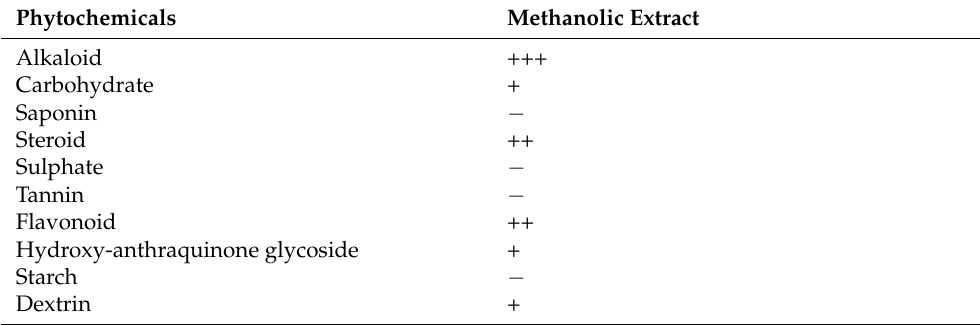
Table 1. Photochemical properties of the MR extracts from the leaf of Molineria recurvata . Phytochemicals Methanolic Extract Alkaloid +++ Carbohydrate + Saponin − Steroid ++ Sulphate − Tannin − Flavonoid ++ Hydroxy-anthraquinone glycoside + Starch −